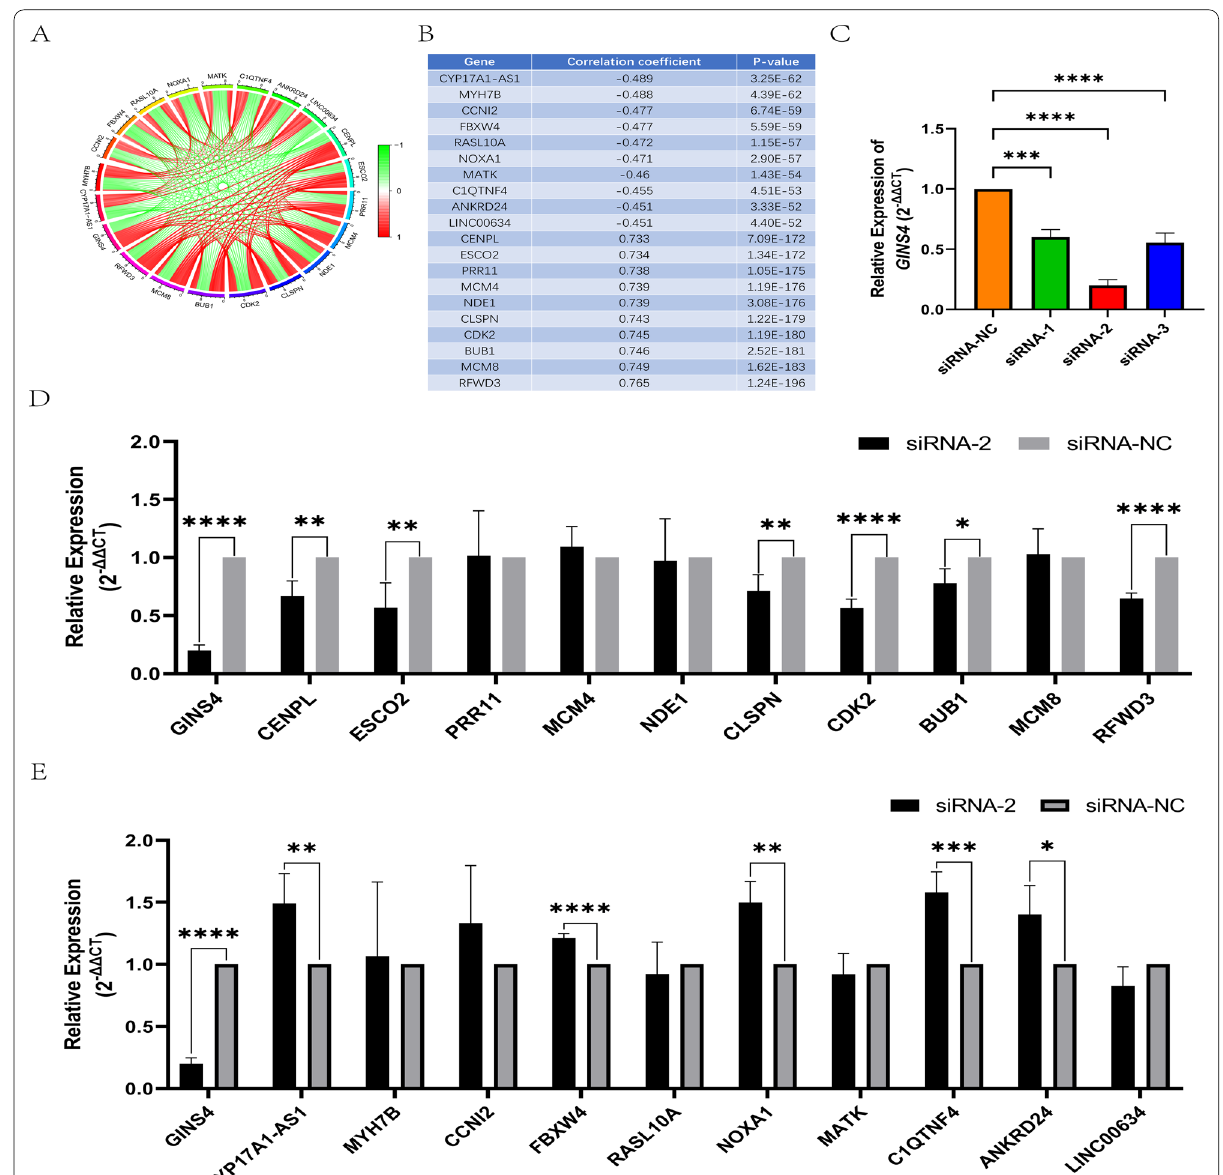
Fig. 8 Co-expression networks show the top 10 genes that are positively and negatively correlated with GINS4 expression in glioma patients. A Circle plot shows 10 positive and 10 negative genes that are most significantly co-expressed with GINS4 ; B Enrichment parameters of the 20 most significant genes co-expressed with GINS4 . C Transfection efficiency comparison of different siRNA sequences for targeted knockdown of GINS4 in U251 cell line; D The expression levels diversification of ten genes that are positively correlated with GINS4 after the knockdown of GINS4 ; E The expression levels diversification of ten genes that are negatively correlated with GINS4 after the knockdown of GINS4 . *p < 0.05, **p < 0.01, ***p < 0.001, and ****p < 0.0001